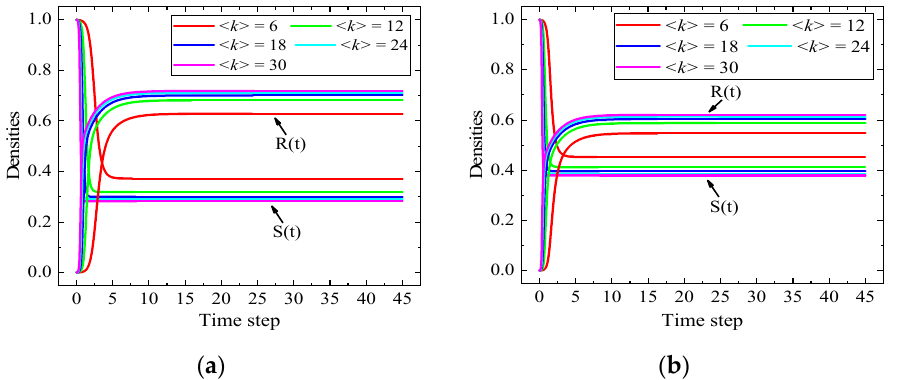
Figure 10. Variation of the density of ignorant people and immunizers when they reach the steady state with the average degree (cid:104) k (cid:105) in ( a ) WS network and ( b ) BA